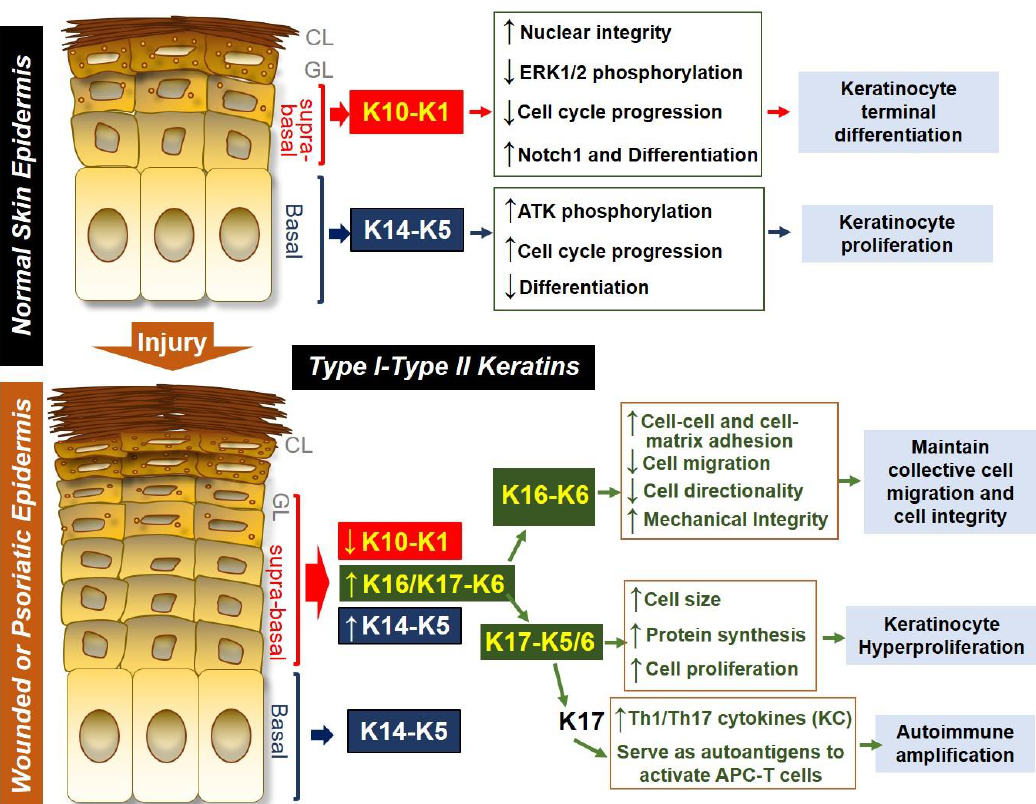
Figure 1. Keratin expression and function in normal skin epidermis or in wounded / psoriatic skin epidermis. In normal skin epidermis, basal keratinocytes express type I and type II keratin pair KRT14 (K14)-KRT5 (K5), which is necessary for maintaining keratinocyte proliferation by increasing AKT phosphorylation, promoting cell cycle progression and inhibiting spontaneous di ff erentiation of keratinocytes. In contrast, cells located at the suprabasal epidermal layers express K10-K1 as the dominant keratin pair, and this keratin pair promotes terminal di ff erentiation of keratinocytes by decreasing ERK1 / 2 phosphorylation, inhibiting cell cycle progression, and increasing Notch1 expression while maintaining nuclear integrity of di ff erentiating cells. During skin injury or in psoriasis, suprabasal keratinocytes downregulate K10-K1, upregulate K14-K5 and strongly induce the expression of K16 / K17-K6. The K16-K6 keratin pair functions to maintain collective cell migration and integrity by increasing cell-cell and cell-matrix contact, decreasing cell migration and directionality while maintaining mechanical integrity. K17 can pair with either K6 or K5 to drive keratinocyte hyperproliferation by increasing cell size and increasing protein synthesis. K17 can also induce Th1 / Th17 cytokine production from keratinocytes, and K17 peptides can also serve as an autoantigen to promote antigen presenting cell (APC)-T cell activation, leading to autoimmune amplification during psoriasis pathogenesis.